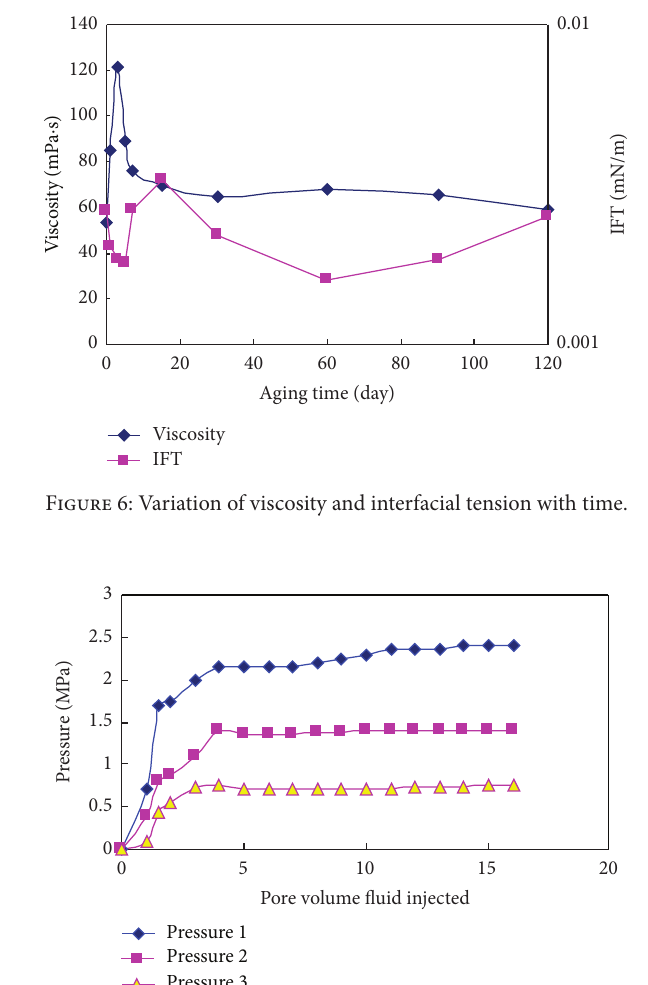
Figure 3: Interfacial tension of the ASP flooding system containing HAPAM.